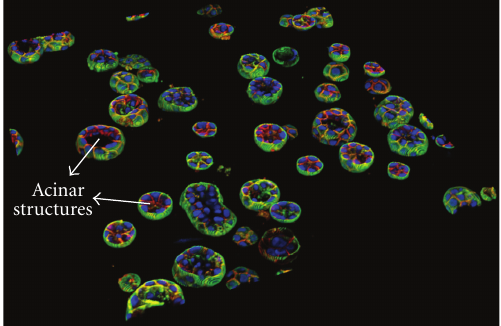
Figure 2: Example of a typical nonmalignant acinar structure cross section. The acinar structure includes polarized epithelial cells and hollow lumen. Basal sides of the cells are surrounded by the ECM proteins and apical sides face the hollow